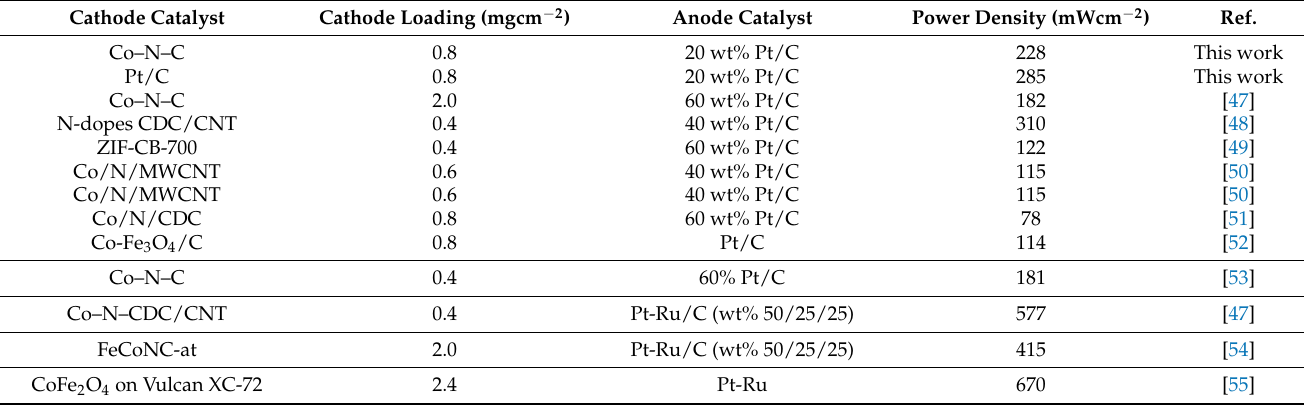
Table 5. Performance of various Co-containing cathode catalysts of